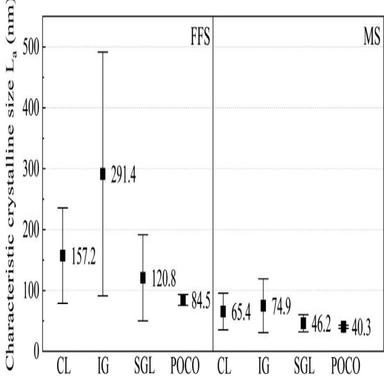
Error bars for characteristic crystalline size La for the four grades of graphite by Raman measurements comparing results from both FFS (left) and MS (right). Inserts are mean values.